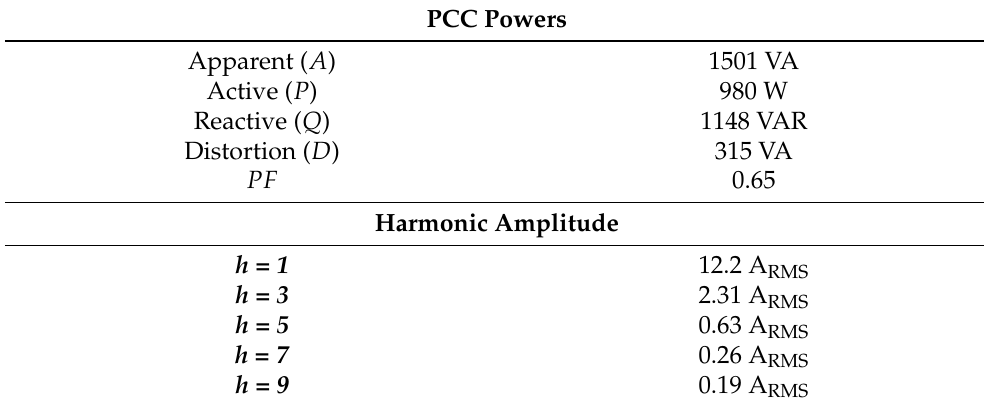
Table 3. Power and harmonic current measurements at the PCC for Figure